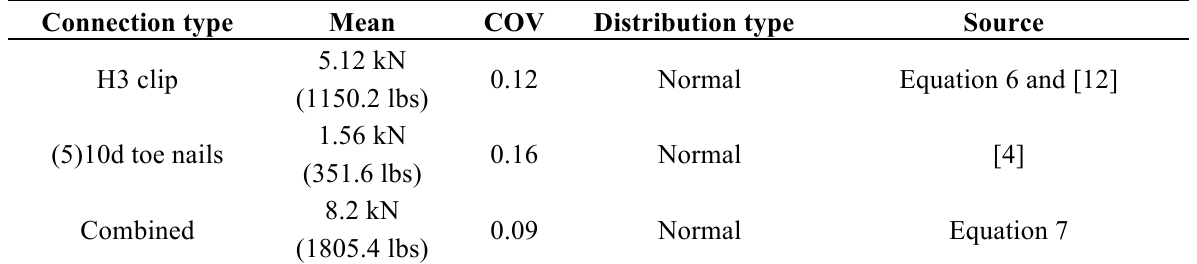
Table 5. Roof-to-wall connection resistance statistics.